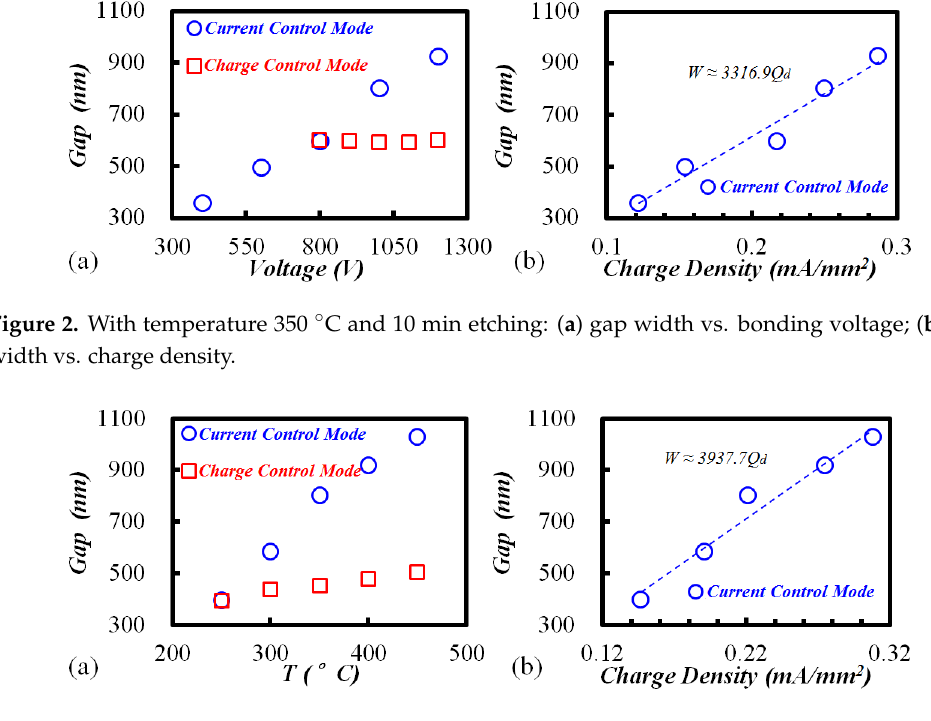
Figure 3. With voltage 1000 V and 10 min etching: ( a ) gap width vs. bonding temperature; ( b ) gap width vs. charge density.